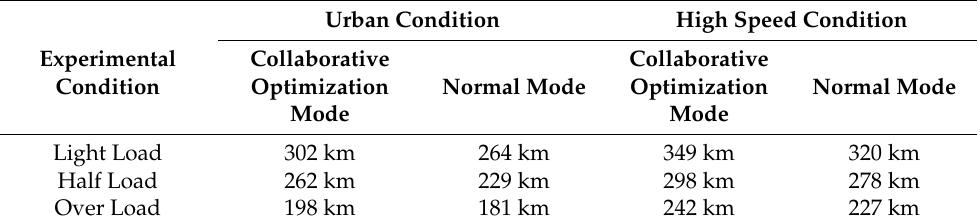
Table 6. The cruising range of electric vehicles under different working